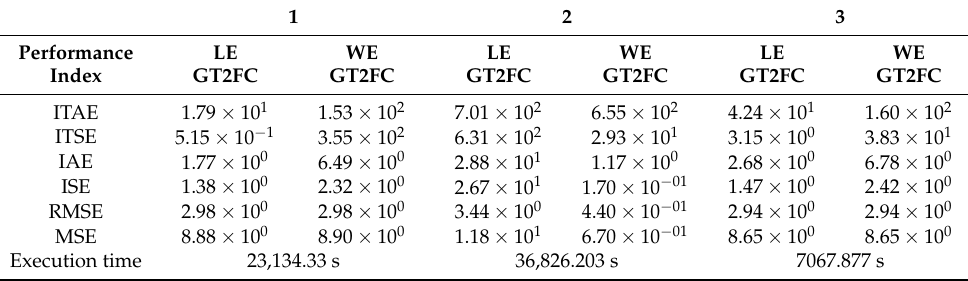
Table 5. Simulations obtained applying one, two, and three disturbances,